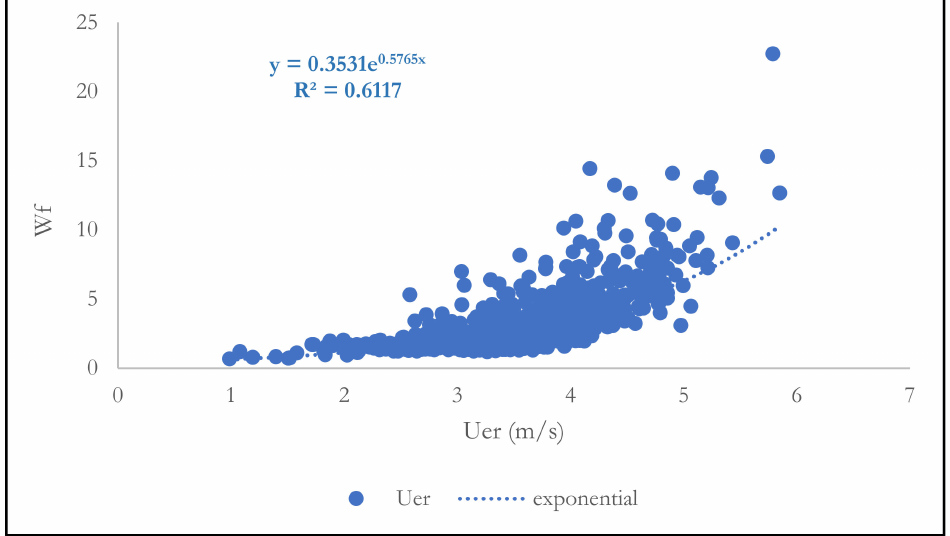
Figure 11. Relationship between Uer and Wf .